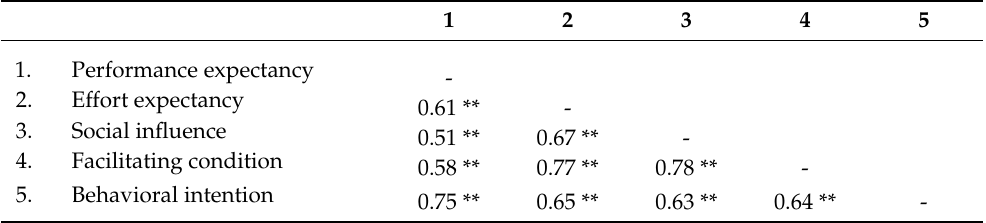
Table 2. Correlations Between the Research Variables.